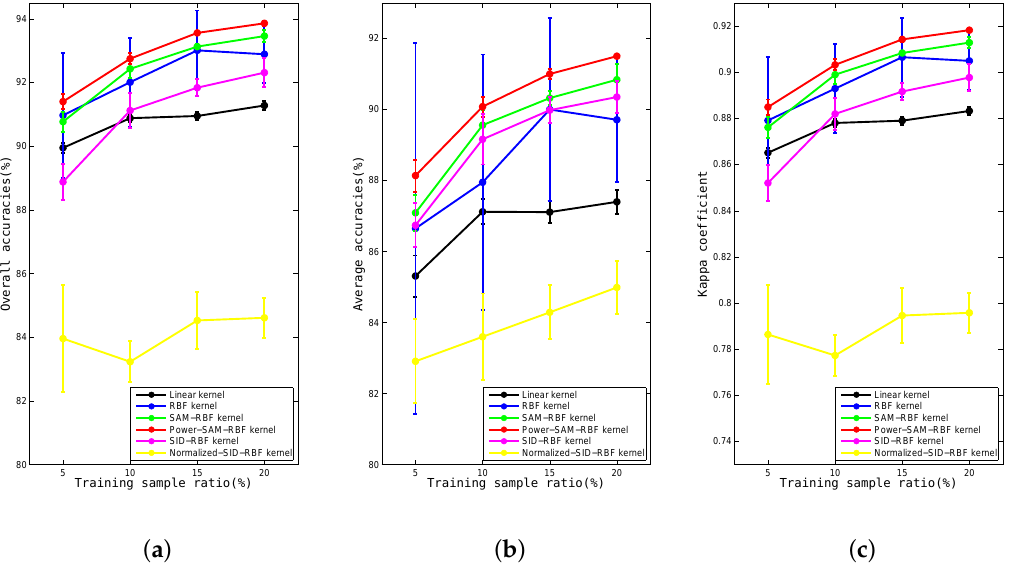
Figure 9. Curves of the ( a )OA, ( b )AA, and( c ) kappa coefficient for the Linear, RBF, SAM-RBF, Power-SAM-RBF, SID-RBF, and Normalized-SID-RBF kernels for proportions of training data of 5%, 10%, 15%, and 20% for the University of Pavia